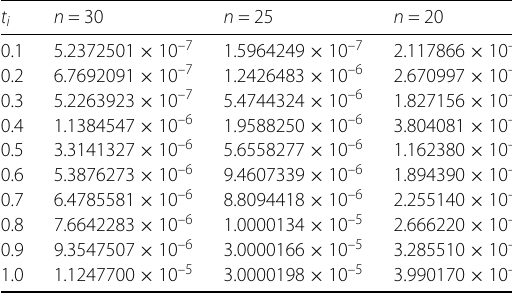
Table 2 Residual error values of Example 5.1 at α = 1